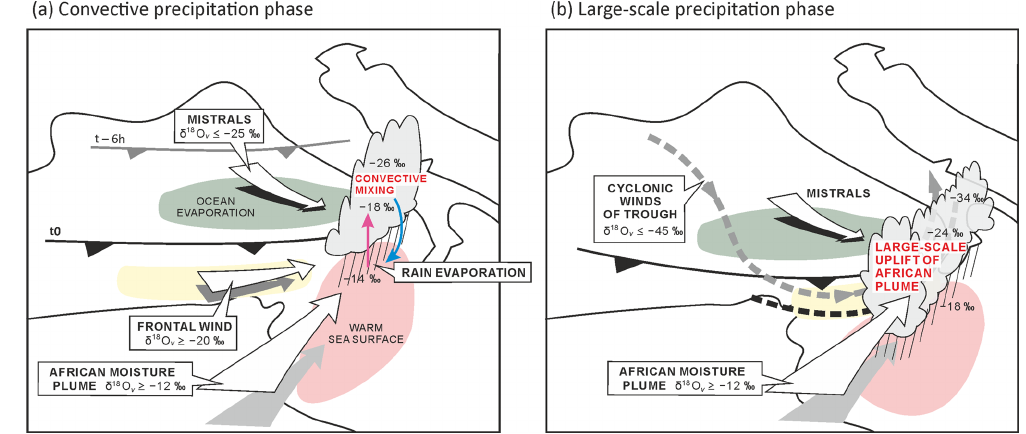
Figure 14. Schematics summarizing the main features of water vapour isotopologues and processes for deep convection upstream of SI and leading to Phase 1 (a) and Phase 2 (b) of the HPE. In (a) and (b) , the white descending arrow indicates the mistral wind behind the edge of the cold front (thick black line). The white arrow in the yellow-shading-encapsulated area illustrates the frontal wind at 850hPa, and the white arrow in the red-shading-encapsulated area (warm sea surface) indicates the elevated African moisture plume. In (a) , convective ascent and precipitating downdraft are depicted by red and blue arrows, respectively. In (b) , the southern edge of the upper trough is indicated by the dashed black line, and the cyclonic flow of the trough is indicated by the dashed grey